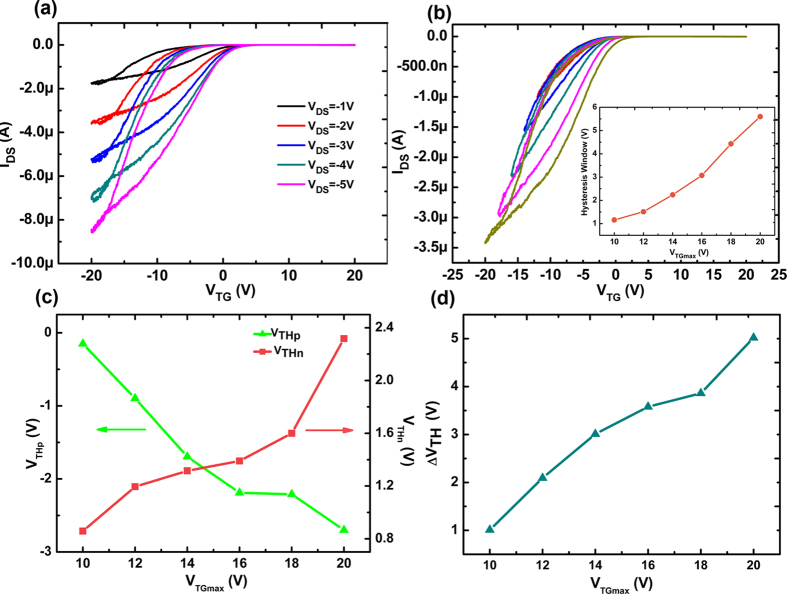
(a) The transfer curves of P(VDF-TrFE) top gate transistors with the VDS ranging from −1 to −5 V. (b) The transfer curves of P(VDF-TrFE) top gate transistors with the VTG sweeping ranges from −10 to −20 V. The inset shows the hysteresis window plotted as a function of VTGmax. (c) The threshold voltage (VTHp and VTHn) under different sweeping directions with the VTG sweeping ranges from −10 to −20 V. (d) The shift of VTHp and VTHn is plotted as a function of VTGmax.